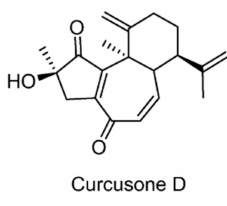
Figure 12. Structure of curcusone